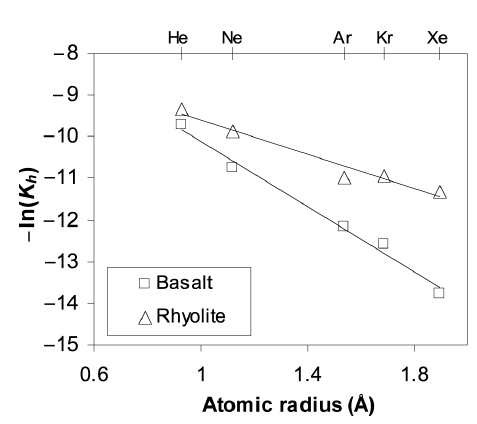
Fig. 5. Solubility (expressed under form of Henry’s constant) of the noble gases as a function of their size at about 1200°C. Solubility exponentially increases from light to heavy noble